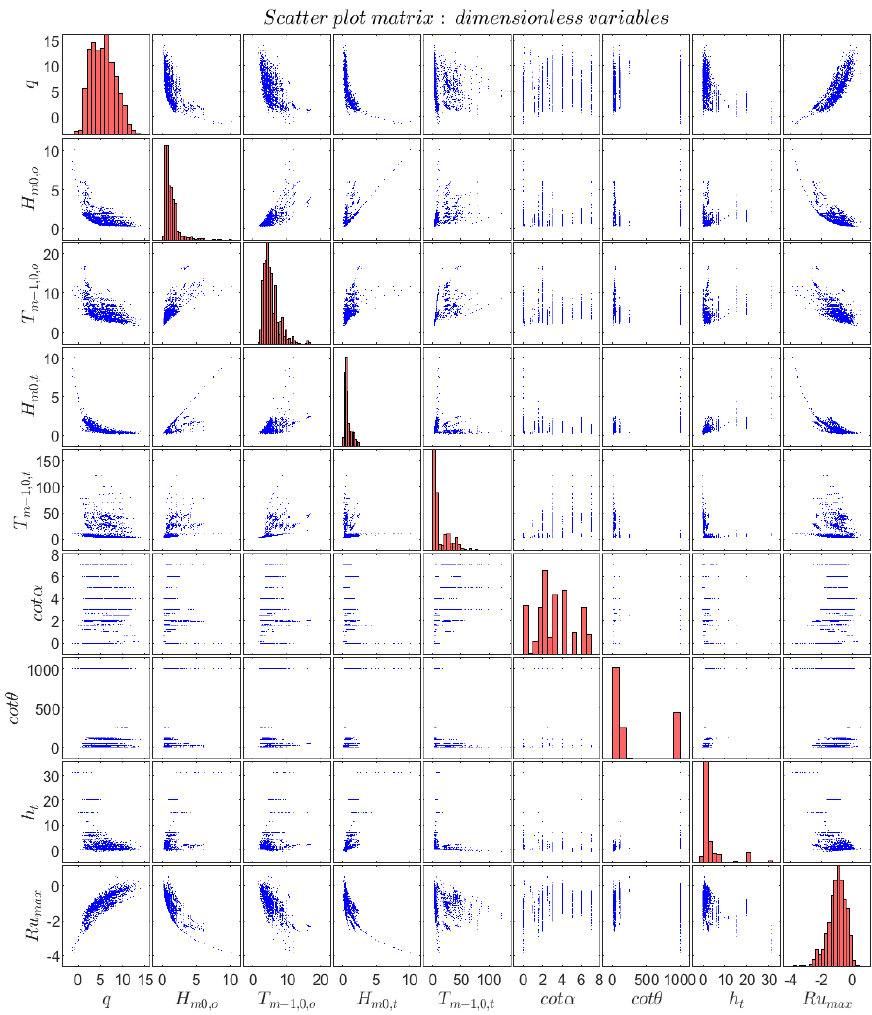
Figure 3. Scatter-plot matrix of dimensionless